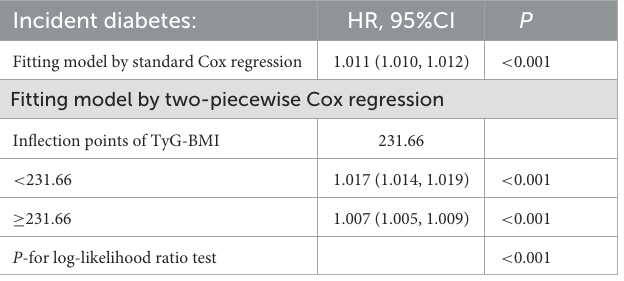
TABLE 6 The result of two-piecewise linear regression model. Incident diabetes: Fitting model by standard Cox regression